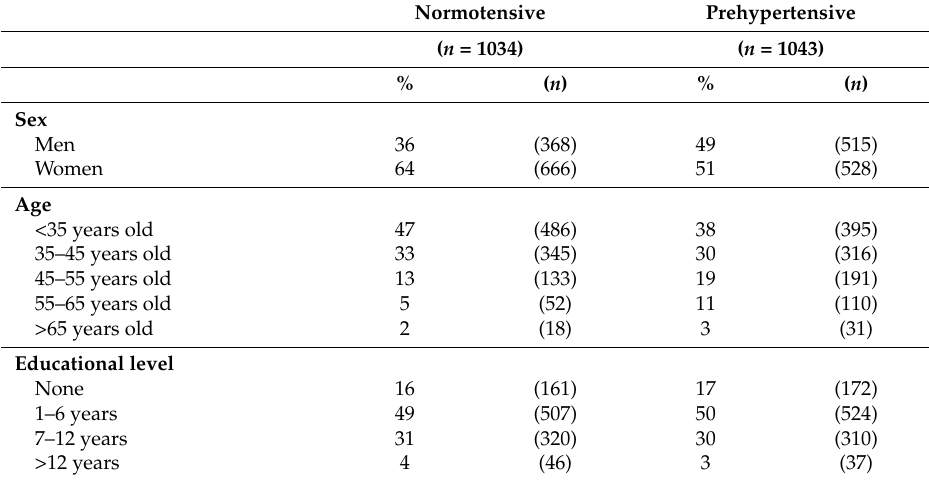
Table 1. Characteristics of the study participants according to baseline blood pressure